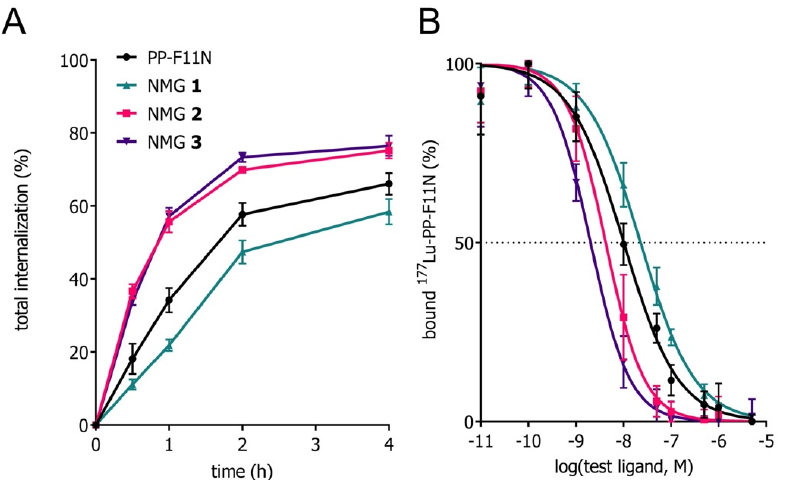
Figure 2. ( A ) Total internalization of 177 Lu-labeled conjugates (2 nM, 5 kBq) in A431-CCK3R cells over 4 h ( n = 3–4 in triplicate). ( B ) Receptor displacement of 177 Lu-labeled CCK2R ligand PP-F11N